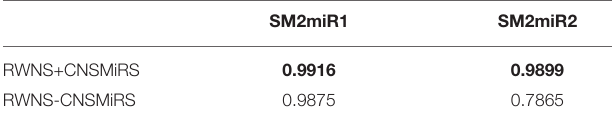
TABLE 5 | Performance comparison considering CNSMiRS or